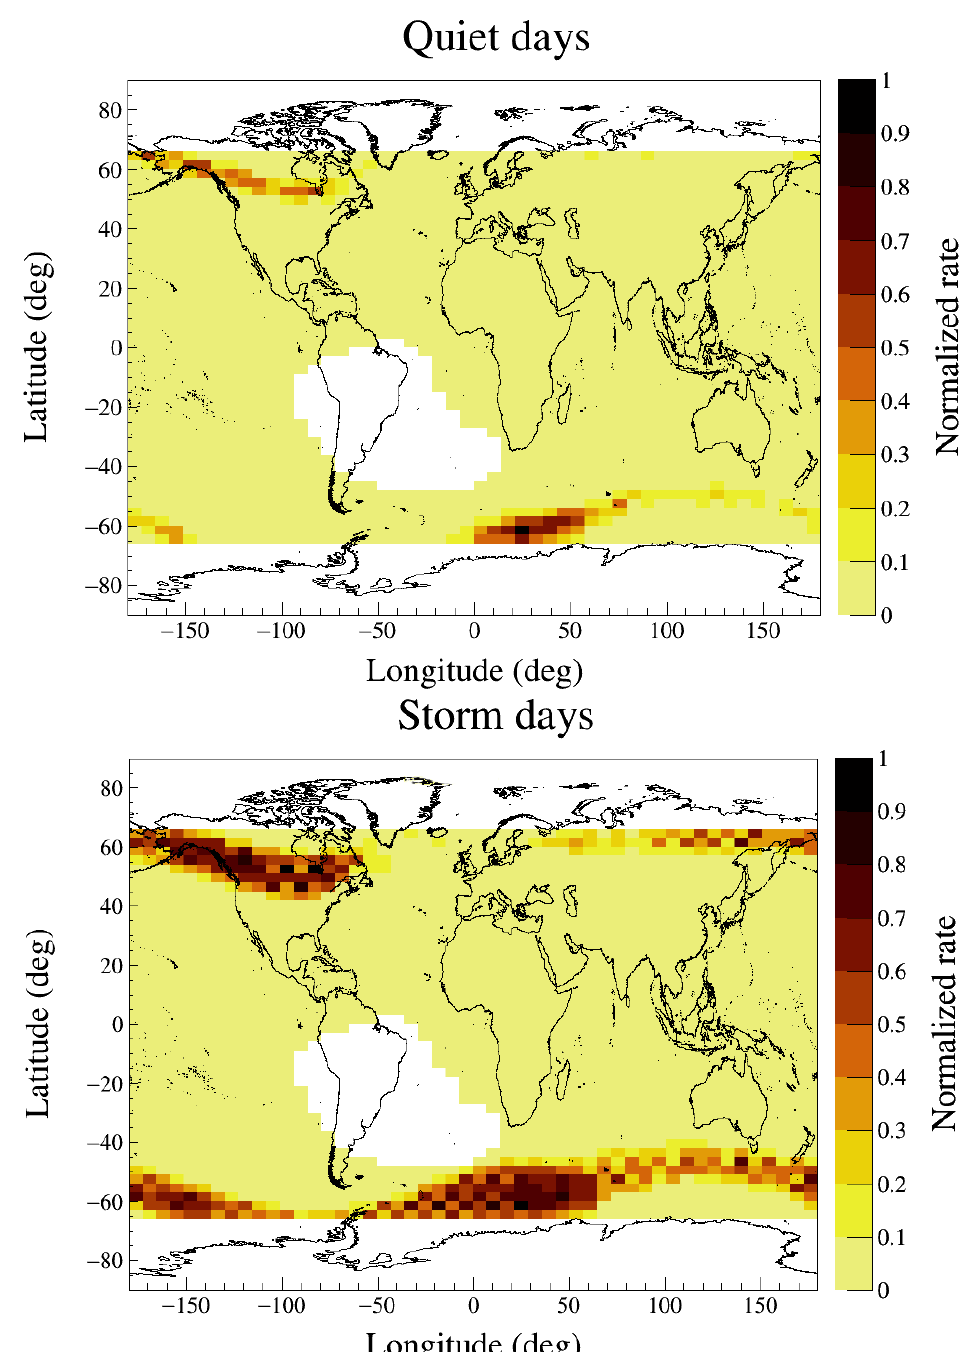
Figure 4. Comparison between an HEPD trigger rate map before the occurrence of the geomagnetic storm, from 20–23 August (upper panel), and after the impact of the storm, from 25 August to 27 (lower panel). The maps are related to trigger configuration T, requiring an above-threshold signal just in the trigger plane and providing the lowest energy threshold for electron detection ( > 3 MeV). For visualization purposes, we excluded the South Atlantic Anomaly region, characterized by extremely high particle